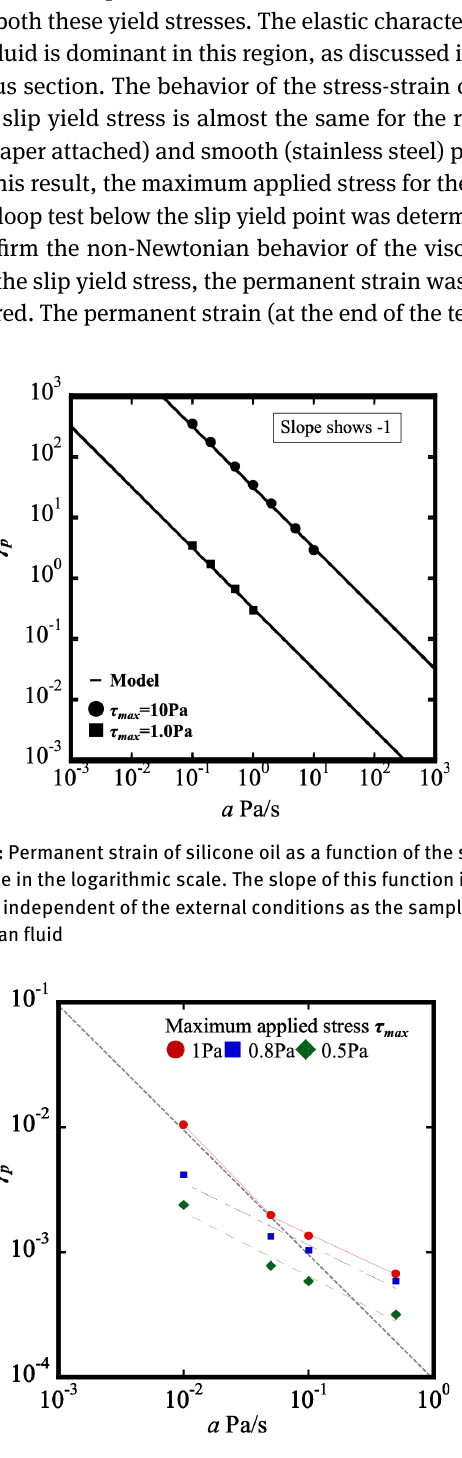
Figure 5: Permanent strain of α -gel O/W emulsion as a function of the stress-ramp rate in the logarithmic scale. None of the slopes are − 1, as the sample is a non-Newtonian fluid. The slope depends on the maximum applied stress τ max (in Pa) and the stress-ramp rate a (in Pa/s), as illustrated in Table